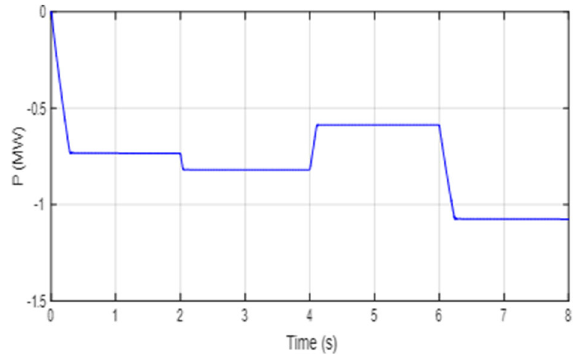
Fig. 19 DFIG stator active power with STW